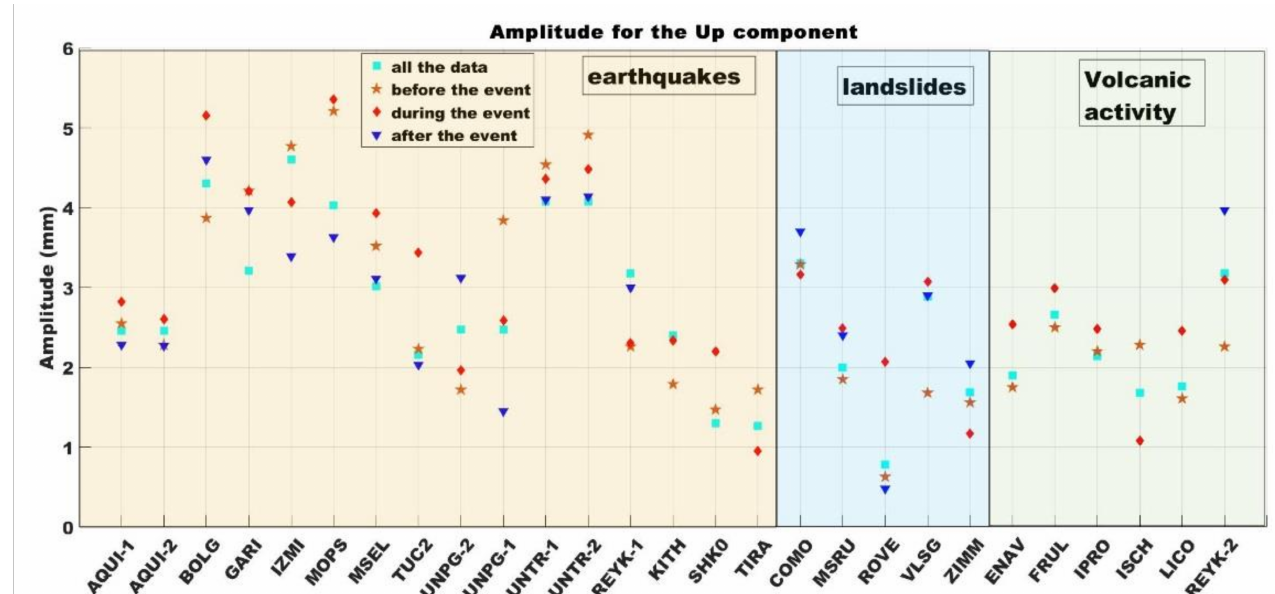
Figure 6. Seasonal signal values for the Up component in the presence of a geophysical event using the four above-mentioned computational